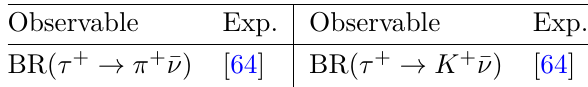
Table 7 . The exclusive τ decays observables used in smelli , along with the relevant experimental measurements and theory papers used in the